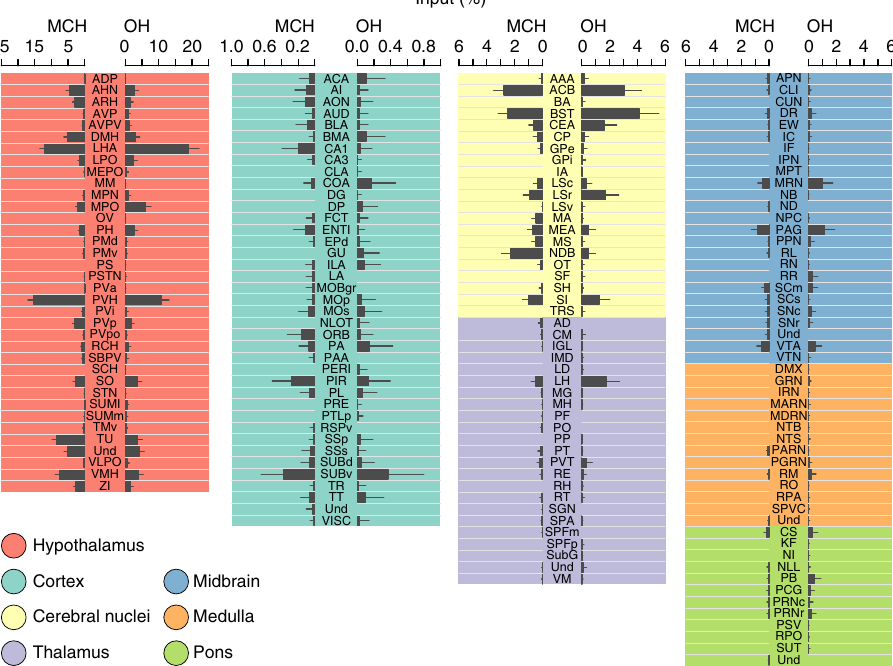
Figure 5 | Fine-grained whole-brain mapping of neural inputs to MCH and OH cells. High-resolution quantification of monosynaptic inputs to MCH and OH neurons across 170 brain areas. Data are means ± s.e.m. of cell percentages found per area in three orexin-Cre brains and six Pmch-Cre brains. ‘Undefined’ refers to cells located outside anatomically named areas of the Allen Atlas. The anatomical acronyms are based on the Allen Atlas, and are fully defined in Supplementary Fig.